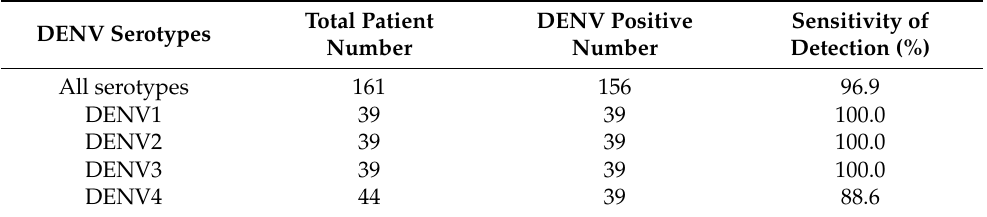
Total Patient DENV Positive Number Number